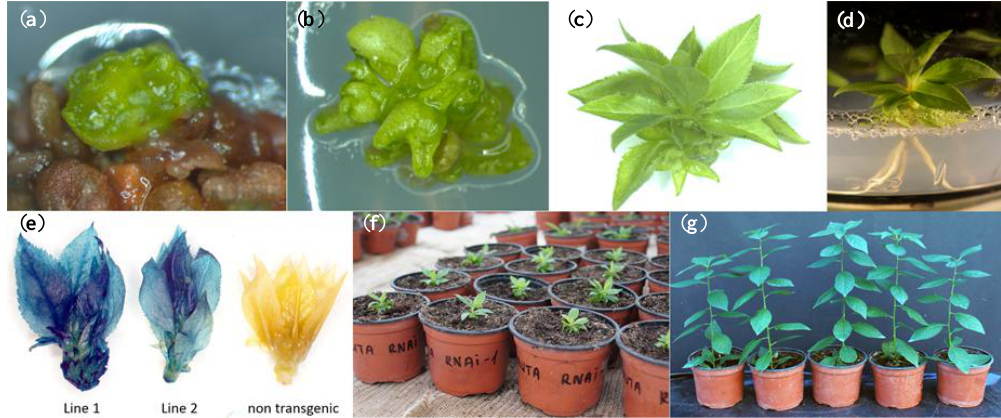
Figure 1. Generation of transgenic rootstock plants. ( a ) Formation of green organogenic callus on leaf explant; ( b ) formation of leaf-like cluster; ( c ) elongated transgenic shoot; ( d ) rooting of selected shoot on medium supplemented with hygromycin; ( e ) blue staining of transgenic shoots due to activity of uidA gene; ( f , g ) establishment of transgenic plum rootstock in greenhouse.